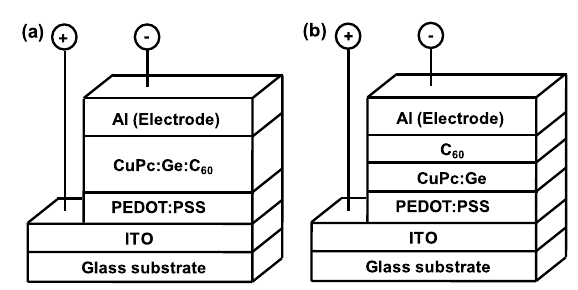
Figure 1. Structure of (a) bulk heterojunction and (b) heterojunction solar cells.